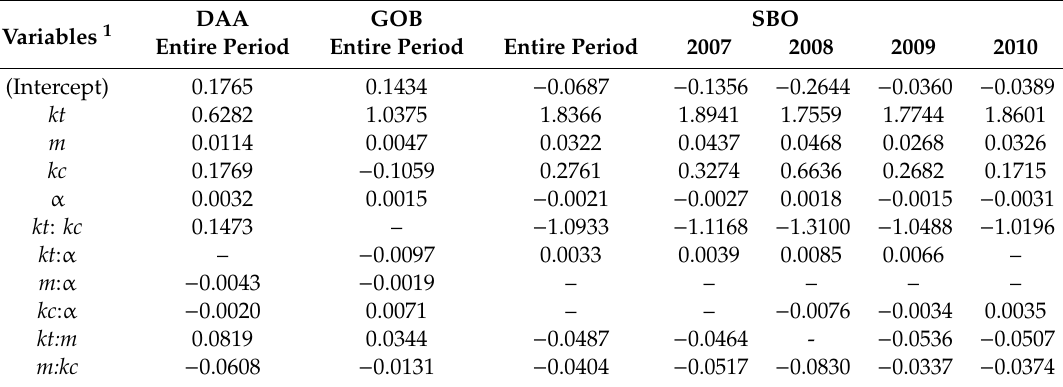
Table3. Setofvariablesandcoefficientsforthesite-adaptationof kt atthethreelocationsindifferentperiods. Variables